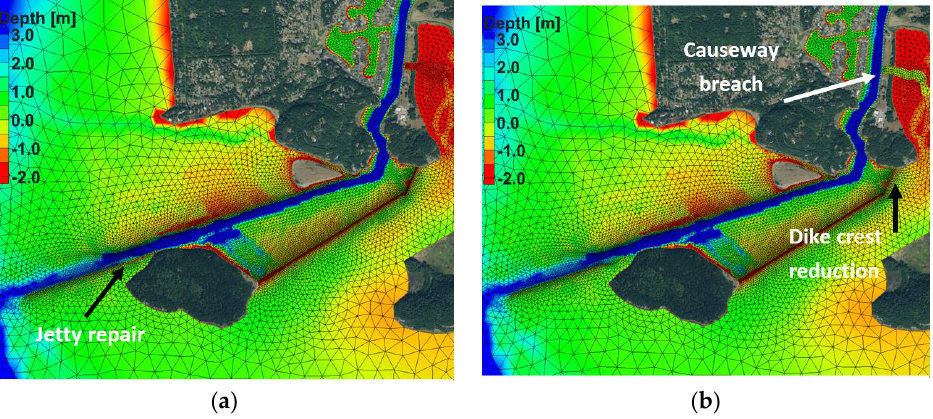
Figure 9. Modified model configuration used for ( a ) SCN-1 South Jetty Repair and ( b ) SCN-2, McGlinn Causeway Restoration. Note—color contours indicate depths (negative elevations) relative to NAVD88 datum.